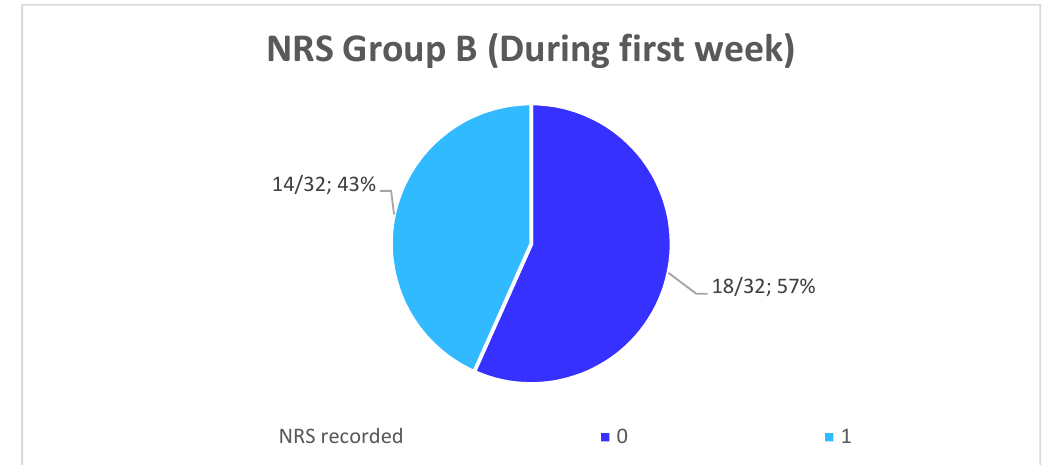
Figure 13. Distribution (numerical and percentage) of the NRS recorded in patients of Group A the first week after surgery.